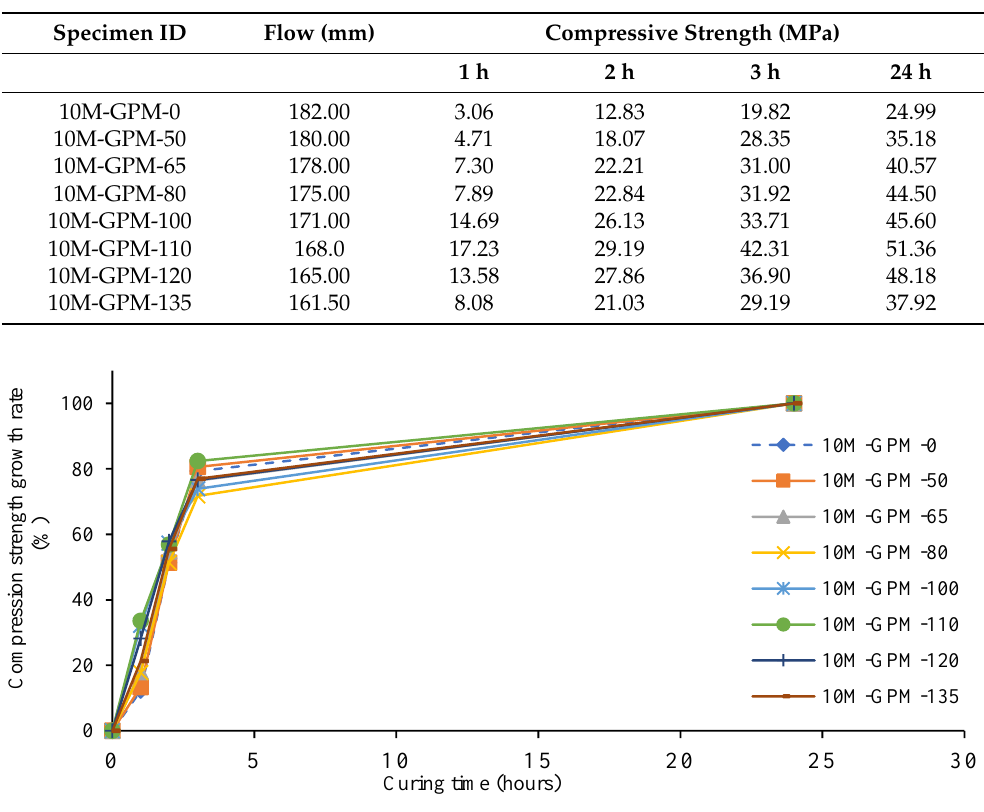
Figure 9. Compressive strength growth rate (%) of the geopolymer material (GPM) using room- temperature sand and preheated sand after 1 h, 2 h, 3 h, and 1 d of hot air curing at a constant temperature of 50 °C.